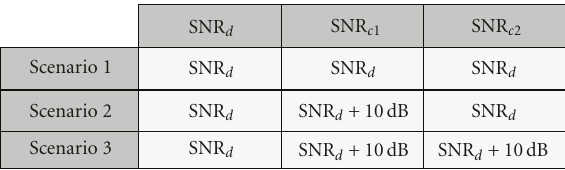
Figure 8: Propagation scenarios considered for Monte Carlo simulations.